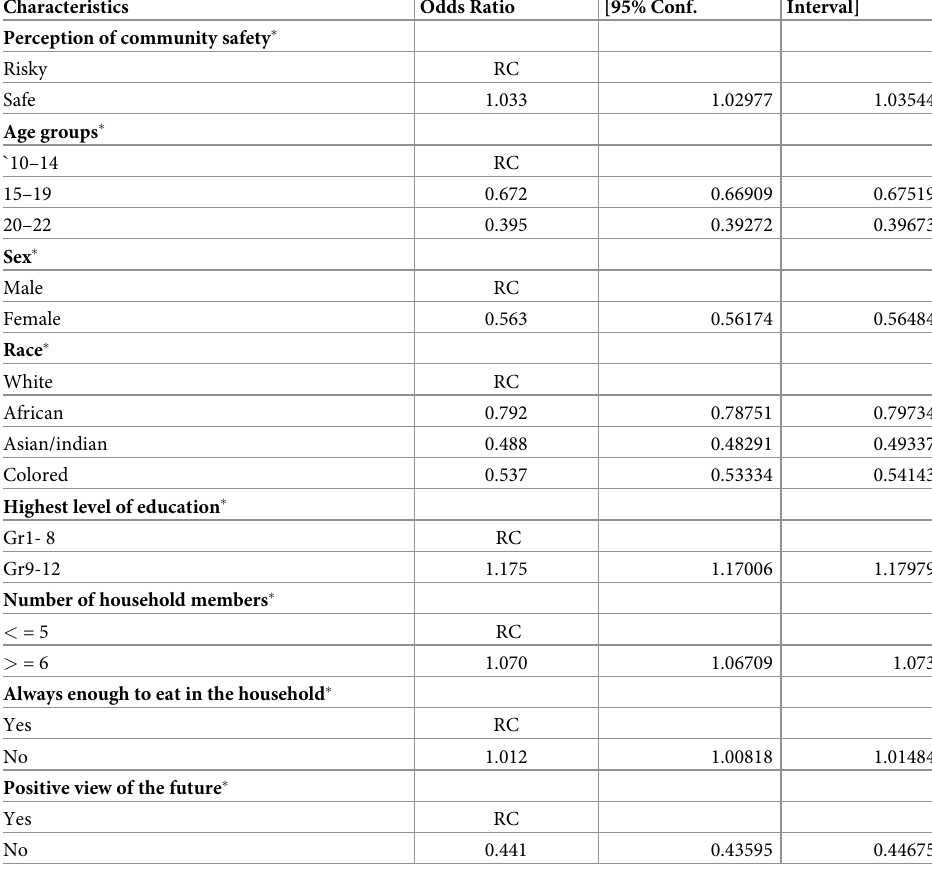
Table 3. Multivariate logistic regression showing the odds of social activity participation by characteristics of youth in South Africa, 2008. Characteristics [95%